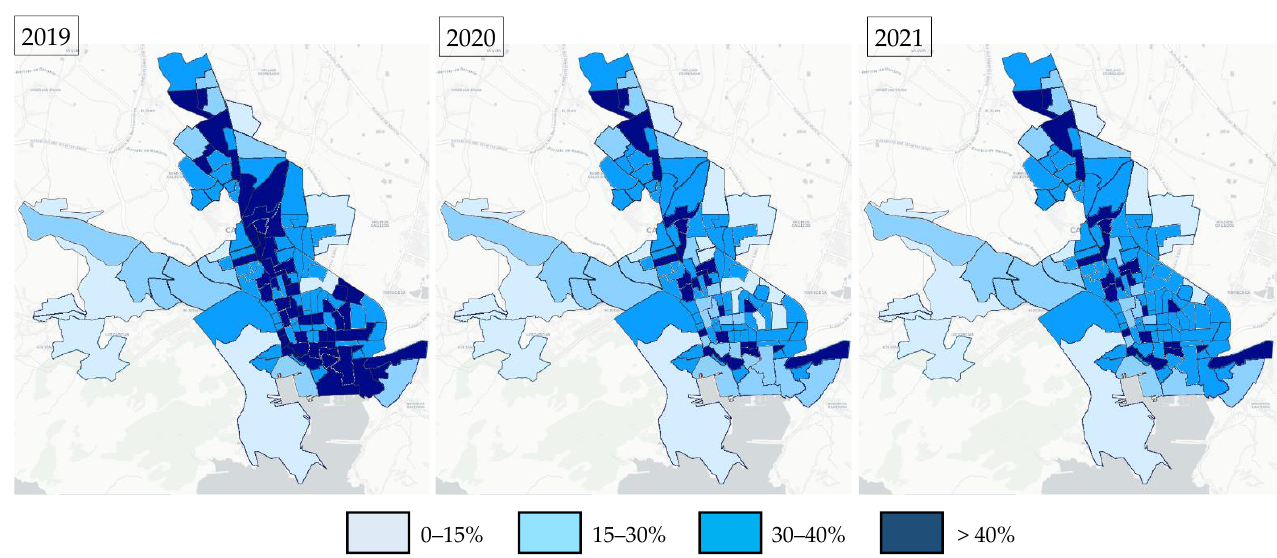
Figure 10. Evolution of the relative weight of the IPTU indicator in the city’s sectors in the months of March and April of 2019, 2020, and 2021.